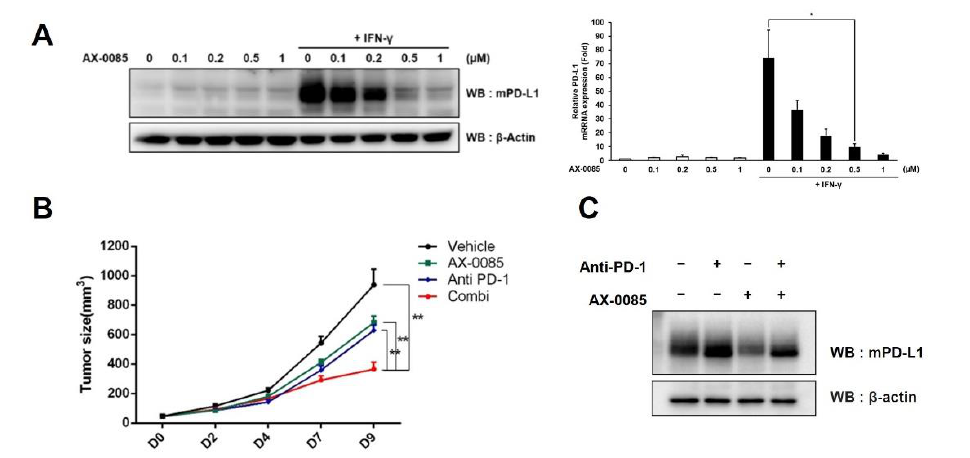
Figure 6. AX-0085 enhances efficacy of anti-PD-1 antibody in vivo. ( A ) Immunoblot showing the inhibition of IFN- γ -induced PD-L1 up-regulation by AX-0085 in a concentration-dependent manner in LLC cells. β– actin was used as the loading control. The concentration of AX-0085 is indicated. Graph shows results from the quantitative real time RT-PCR. Data are mean ± SEM of three independent experiments. Statistical significance is indicated (* p -value of <0.05, from Student’s t -test). ( B ) Graph showing growth of xenograft tumors ( n = 5; ** p -value of <0.01 from unpaired two-tailed t -test). ‘Combi’ indicates combinatorial treatment of AX-0085 and anti-PD-1 antibody. ( C ) Immunoblot showing the inhibition of PD-L1 expression in tumors by AX-0085 with or without anti-PD-1 antibody. β– actin was used as the loading control.